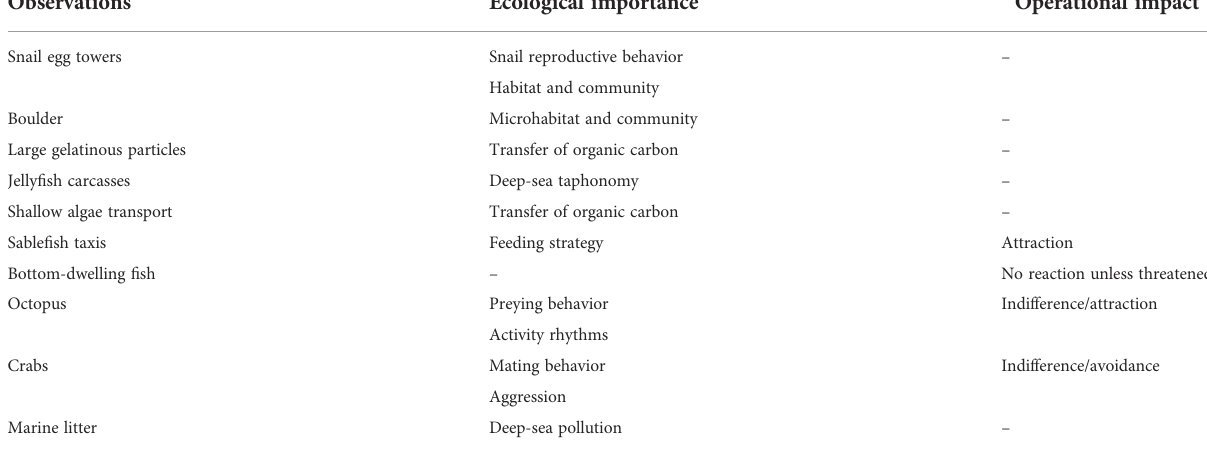
TABLE 1 Selected observations made with the crawler during a decade-long period (i.e., 2009 – 2021), alongside their ecological importance and/ or operational